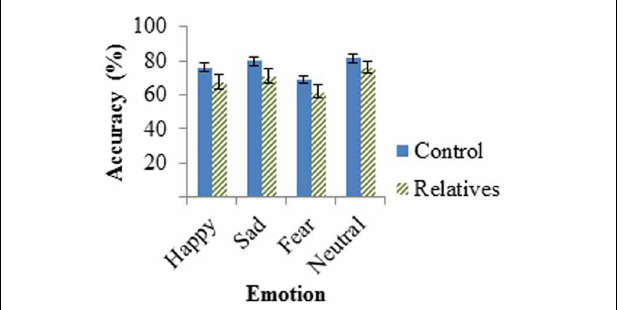
FIGURE 1 | Mean accuracy of controls and relatives for each emotion tested in the AIT, with standard error of the mean (SEM)